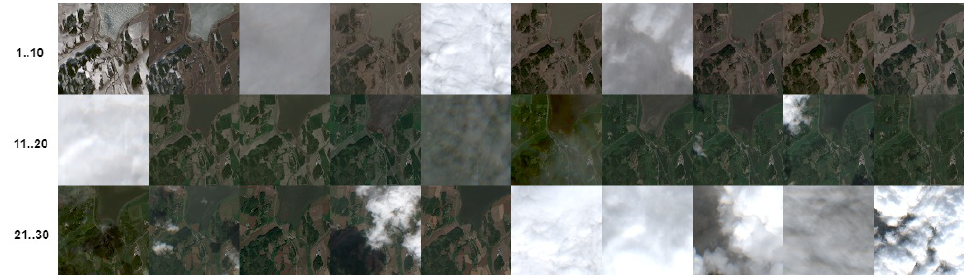
Figure 3. Dataset sample showing a 30 week time series of a farm in natural colour. Images are indexed 1–30, roughly equal to weeks